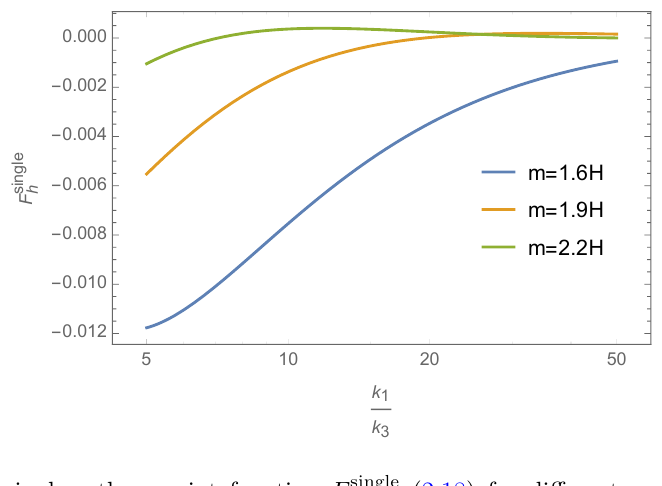
(2.18) for di(cid:11)erent masses in Single-(cid:12)eld h q _ (cid:30) ; (cid:21) h = H 2 ; (cid:3) = 3 0 . 2 _ (cid:30) 0 _ (cid:30) 0